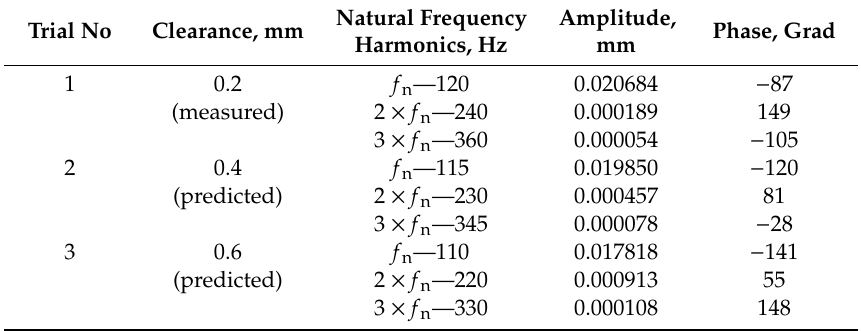
Figure 8. Natural frequency ( a ), amplitudes ( b ) and phases ( c ) of harmonics during transient vibrations of gearbox shaft without the bolted joint opening. In the course of gearbox operation, the amplitude of the shaft oscillations gradually changed and the bolted joint opening increased from the minimum value (about 0.05 mm) to the maximum (1.05 mm) when bolts may break due to plastic elongation and loosening. Results of the